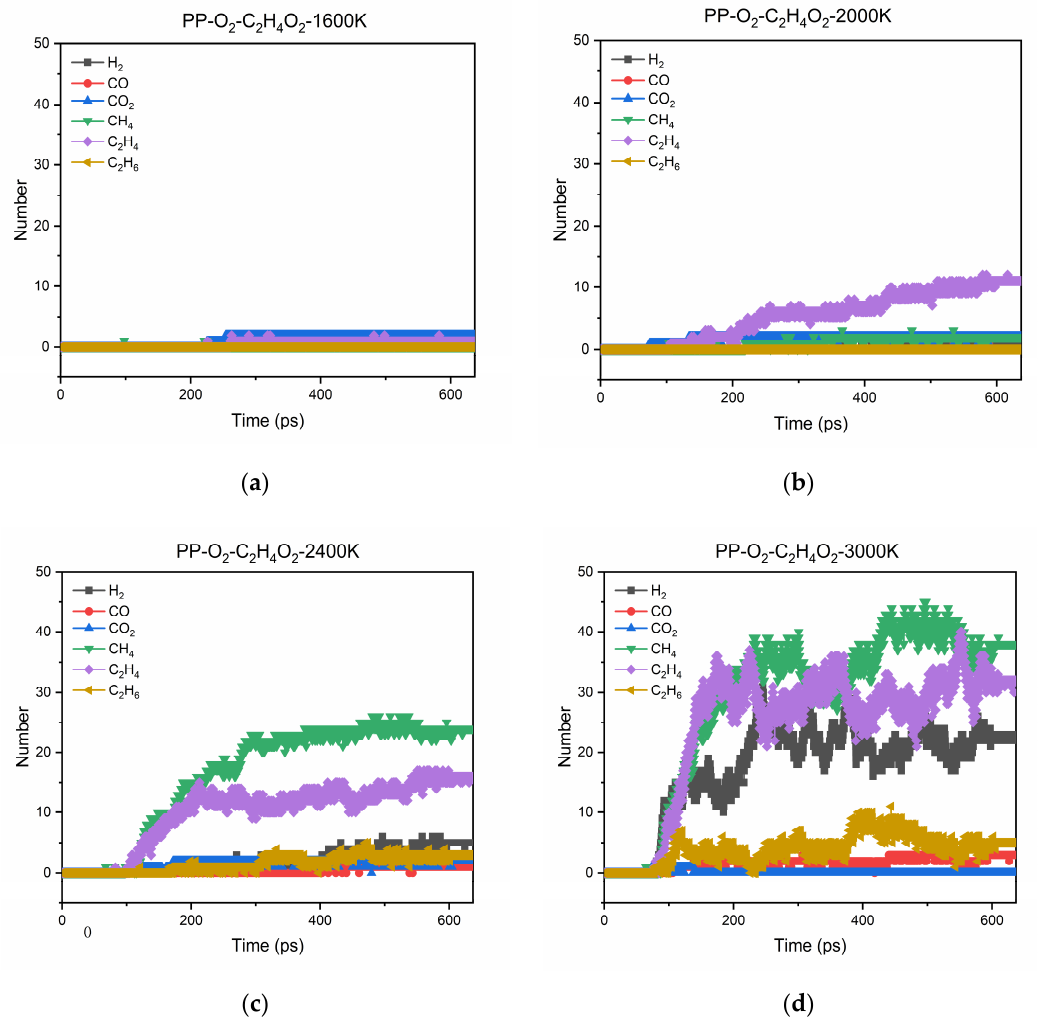
Figure 3. Evolution of six typical small molecule products as a function of time in the aging simulation: ( a ) 1600 K; ( b ) 2000 K; ( c ) 2400 K; ( d ) 3000 K.